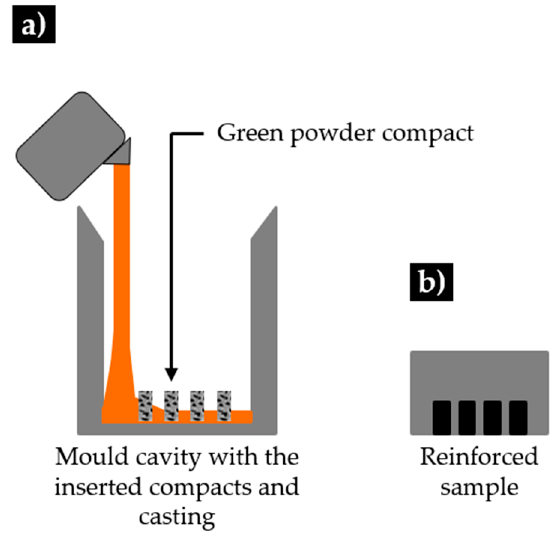
Figure 2. Scheme of the ( a ) mold with the inserted green compacts and ( b ) reinforced specimen (adapted from [40] ). Table 1. Nominal chemical composition of the high-Cr white cast iron (WCI) (wt.%).